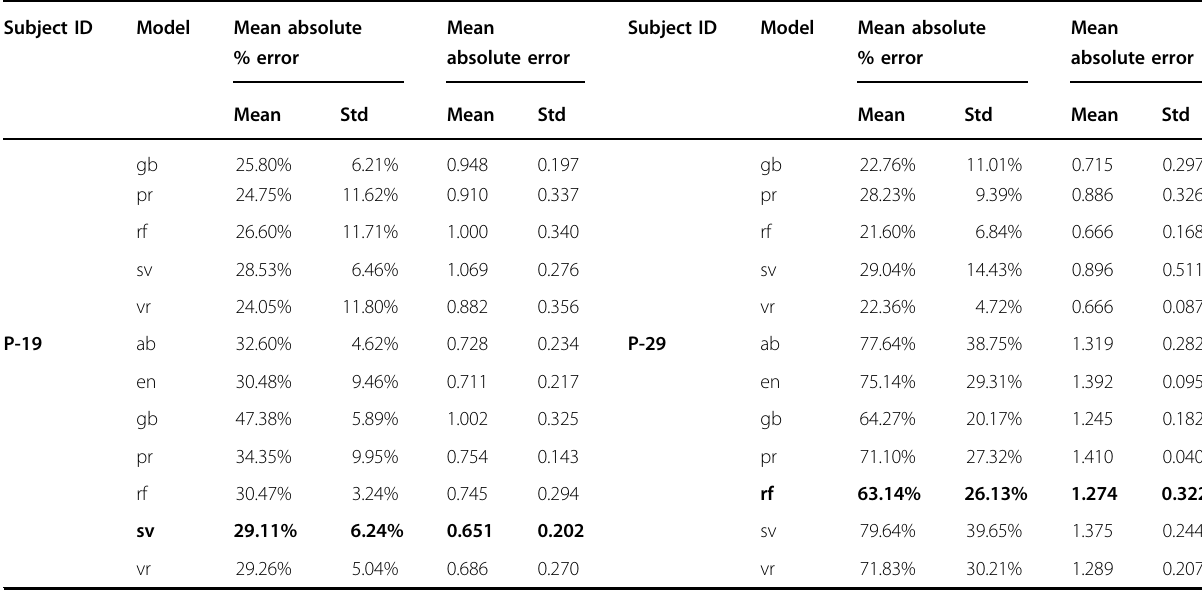
The best performing models for each subject are highlighted. Performance metrics of mean absolute percentage error and mean absolute error are shown. Seven different ML models were used in each subject: Adaboost regressor (ab), elastic net (en), gradient boosting tree regressor (gb), poisson regressor (pr), random forest regressor (rf), support vector machine regressor (sv), and voting regressor